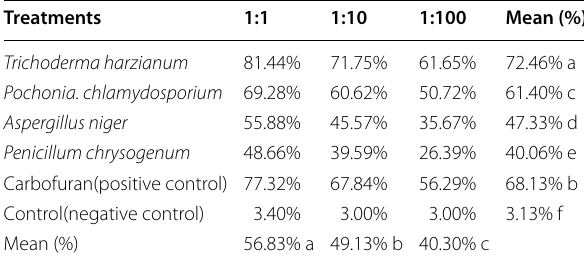
Each value is the mean of 5 Replications. A letter followed by the same alphabet doesn’t differ significantly